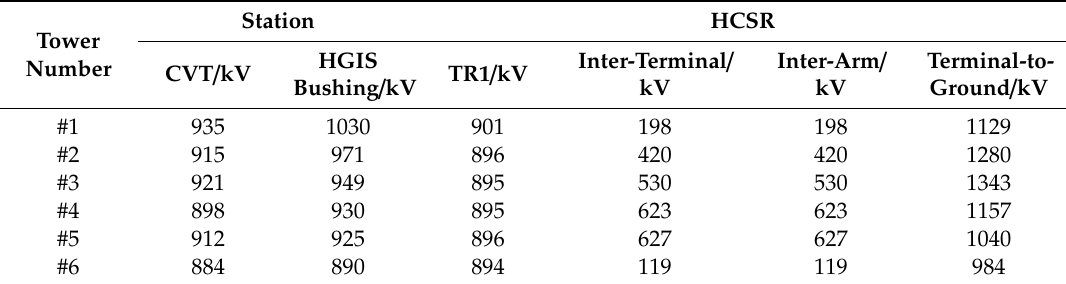
Figure 8. Inter-terminal and inter-arm overvoltage of the HCSR. Table 13. Overvoltage of the equipment in current sharing state.